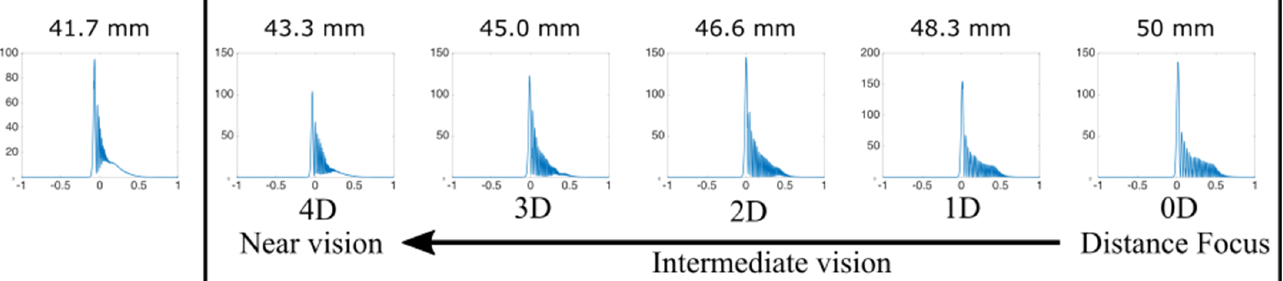
Figure 11. Horizontal PSFs of the combined APM + FL with 𝛼 = 80 = 251 𝜋⁄ , intended for an EDOF IOL, in different 𝑧′ -image positions. The rectangle highlights the useful range of vision at the IOL plane.